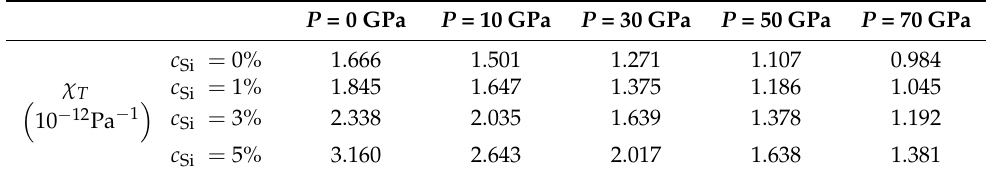
Table 3. Si concentration and pressure dependence of isothermal compressibility χ T for WSi at T = 300 K.